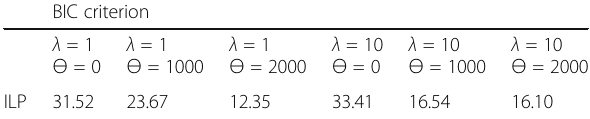
Table 3 DER results obtained using ILP clustering algorithm